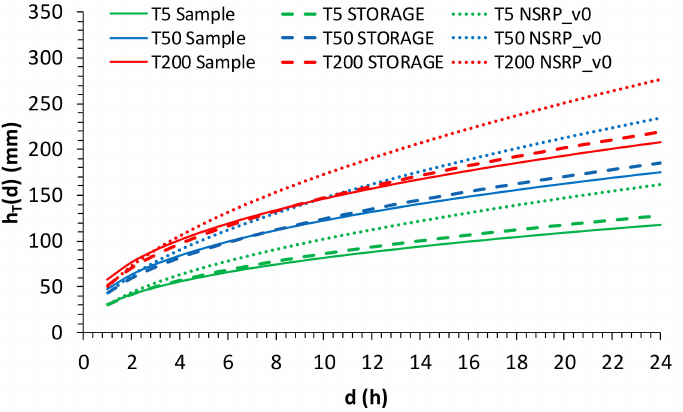
Figure 25. Montalto Uffugo rain gauge: comparison between STORAGE and NSRP_v0 performances, focusing on ADF